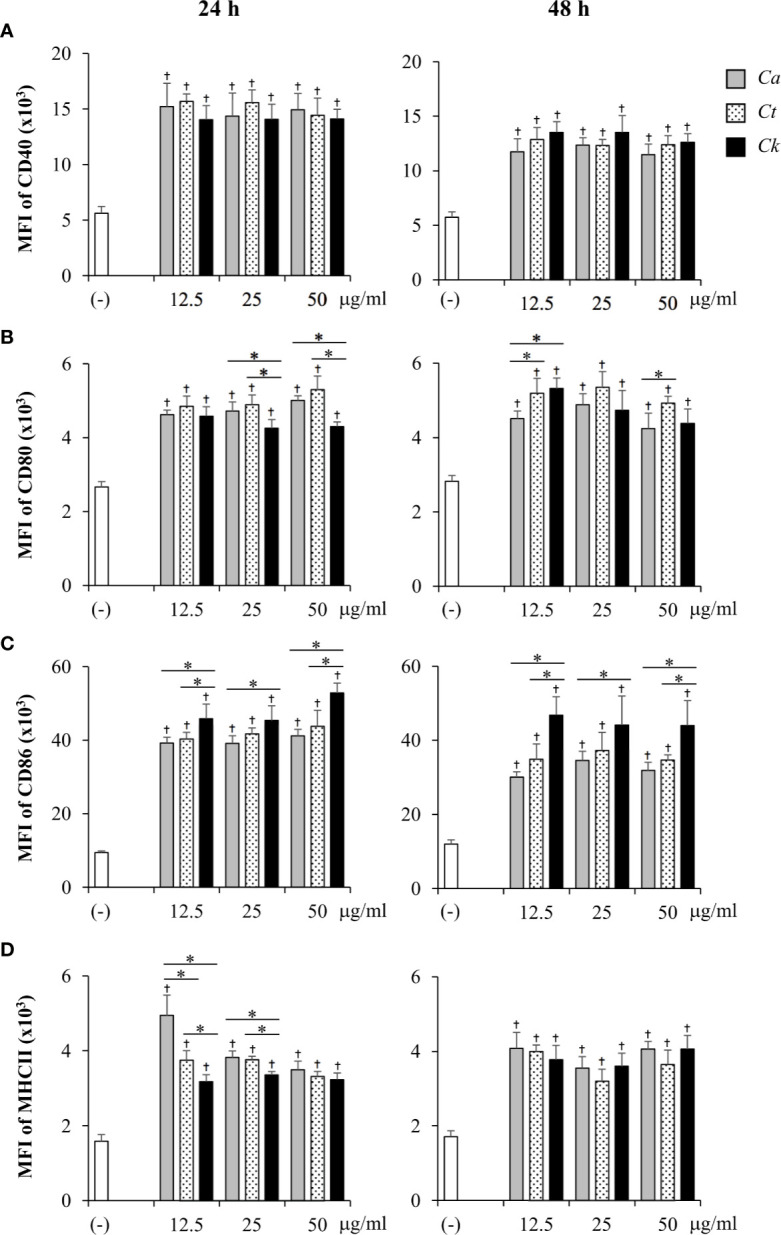
Differential DC maturation following stimulation with distinct Candida β-glucans. Bone-marrow derived dendritic cells (BMDCs) were stimulated with 12.5, 25, and 50 µg/ml of β-glucans isolated from C. albicans, C. tropicalis, and C. krusei for 24 h and 48 h, and the geometric mean fluorescence intensity (MFI) of dendritic cell (DC) maturation markers (A) CD40, (B) CD80, (C) CD86, and (D) MHC class II on CD11c+ cells were determined using histogram analyses. n = 5; data are representative of two independent experiments. †
p < 0.05 compared with unstimulated BMDCs, *p < 0.05. (-), unstimulated BMDCs; Ca, C. albicans; Ct, C. tropicalis; Ck, C. krusei.